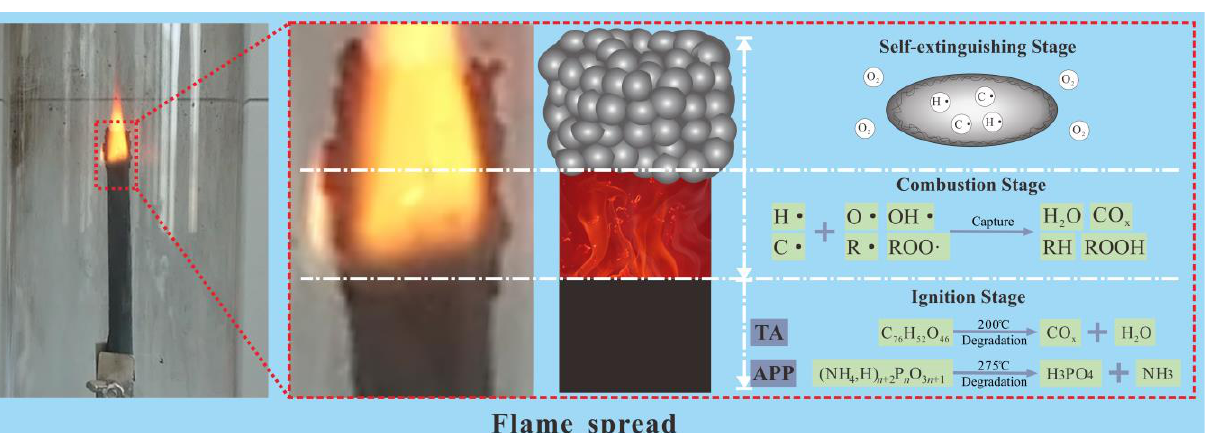
Figure 7. Flame divided into three stages: ignition, combustion, and self-extinguishing.